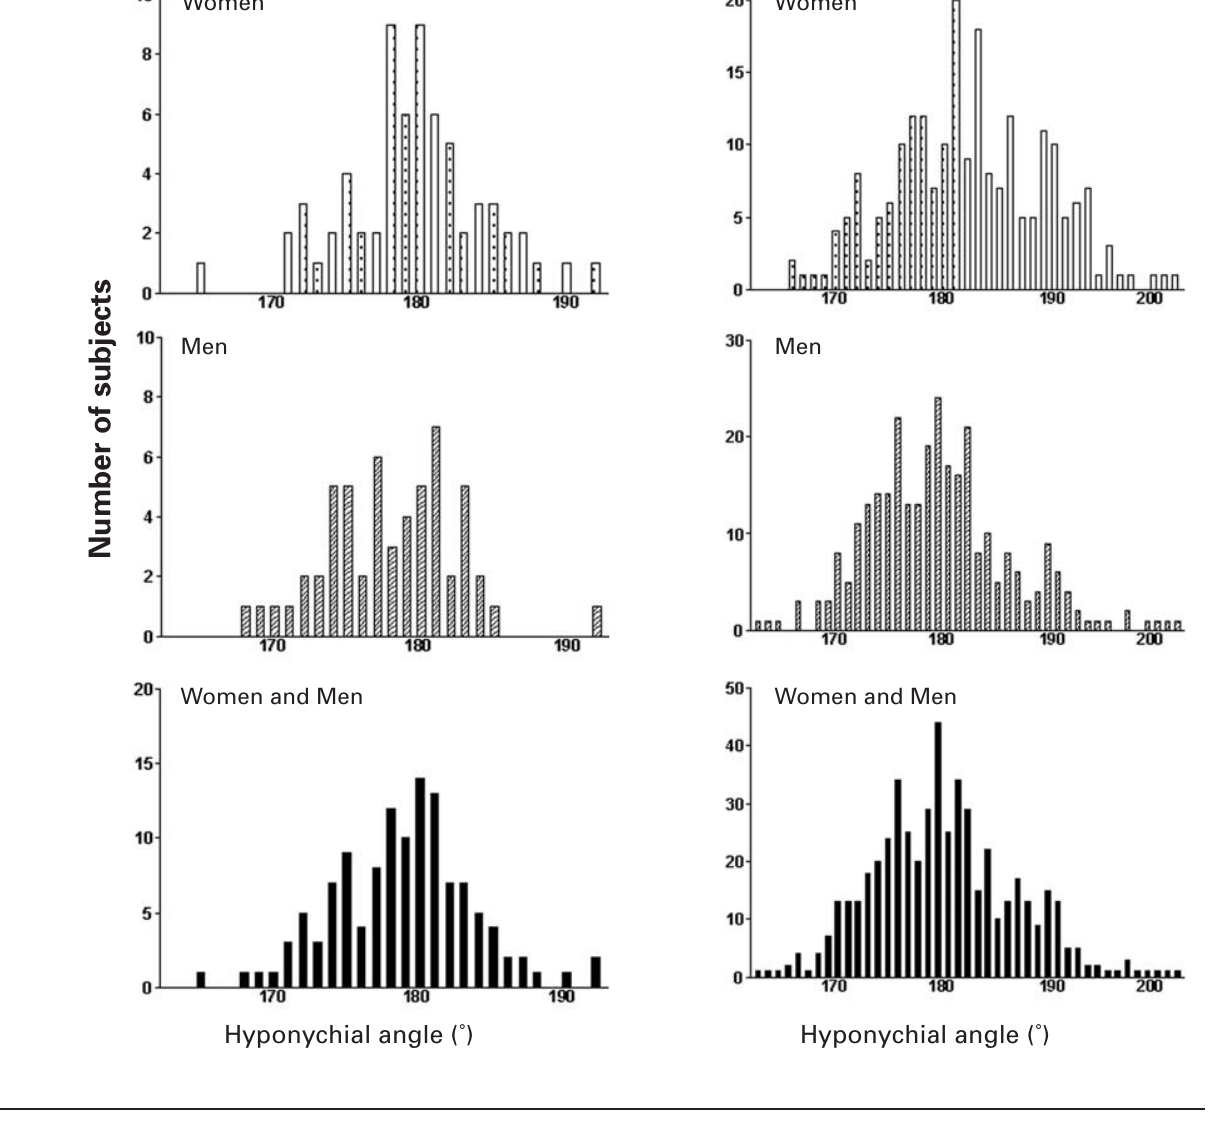
Table 3 Age distribution of hyponychial angles among control subjects and